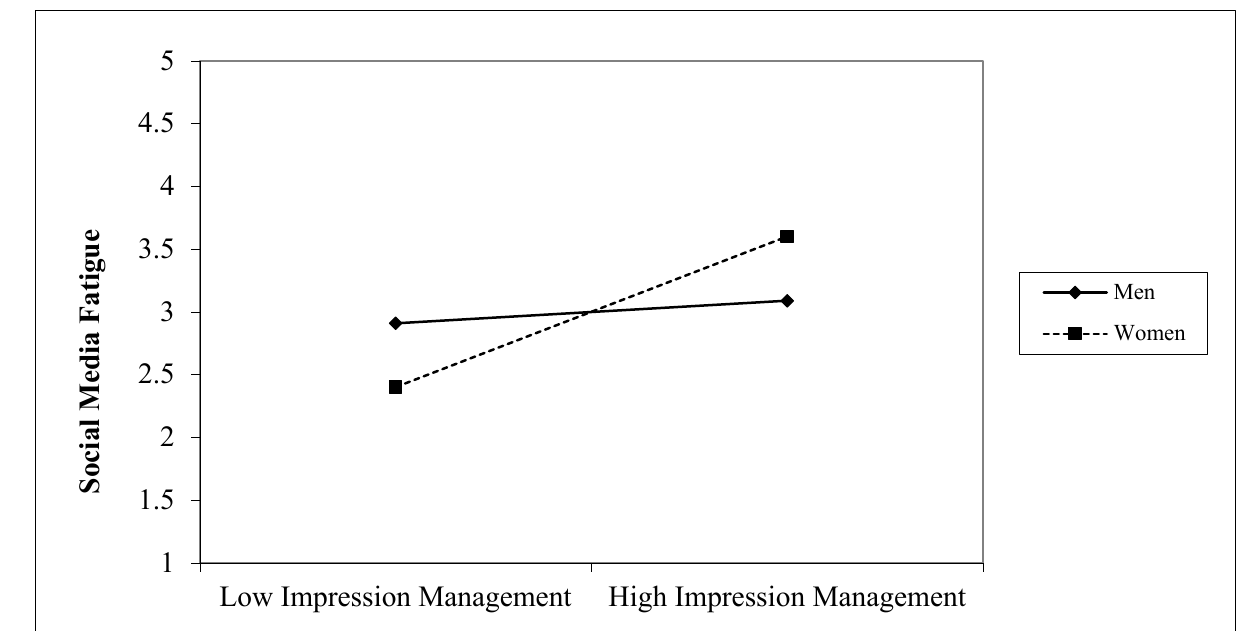
Figure 2. Interaction between social media fatigue and IM concerns on gender.